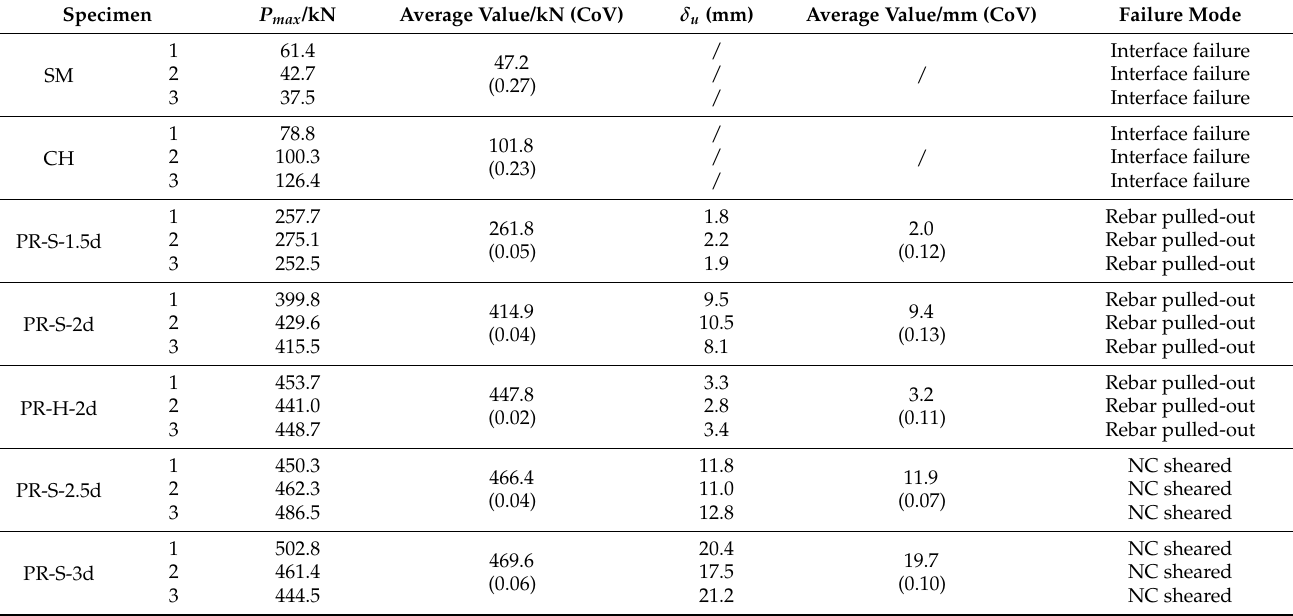
Table 5. Experimental results of push-out